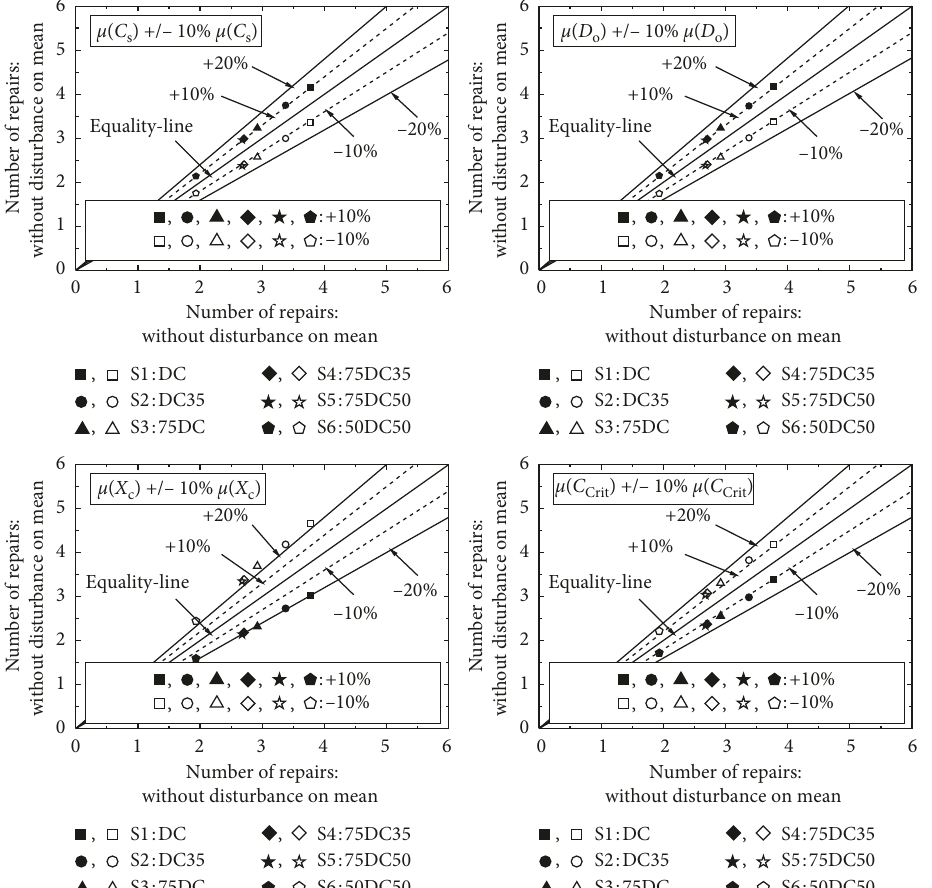
Figure 13: Sensitivity of the mean of four random variables to the total expected number of repair applications.